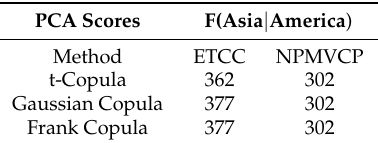
Table 22. Change point detection by ETCC and NPMVCP of PCA and copulas with real exchange currency data of America (1/3/2013 to 10/3/2014) and Asia (1/4/2013 to 10/6/2014).